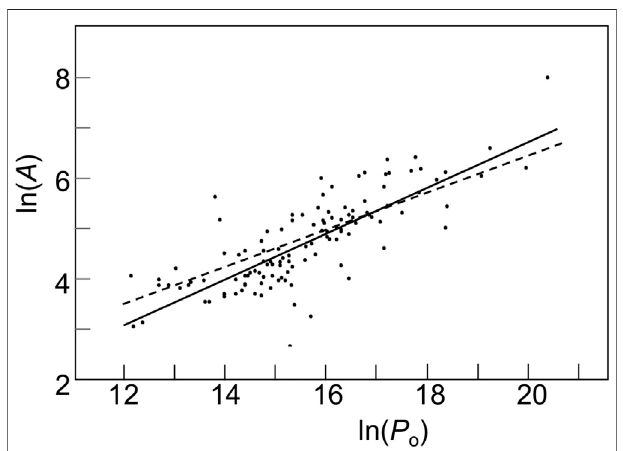
FIGURE. 1 | Log-log plot of the original data of Taagepera [1]. The solid lineisthebest fi tgiven by Eq. 3 ,whereas the dashed lineisthe (forced) fi twith a cube-root law, leading to Eq. 4